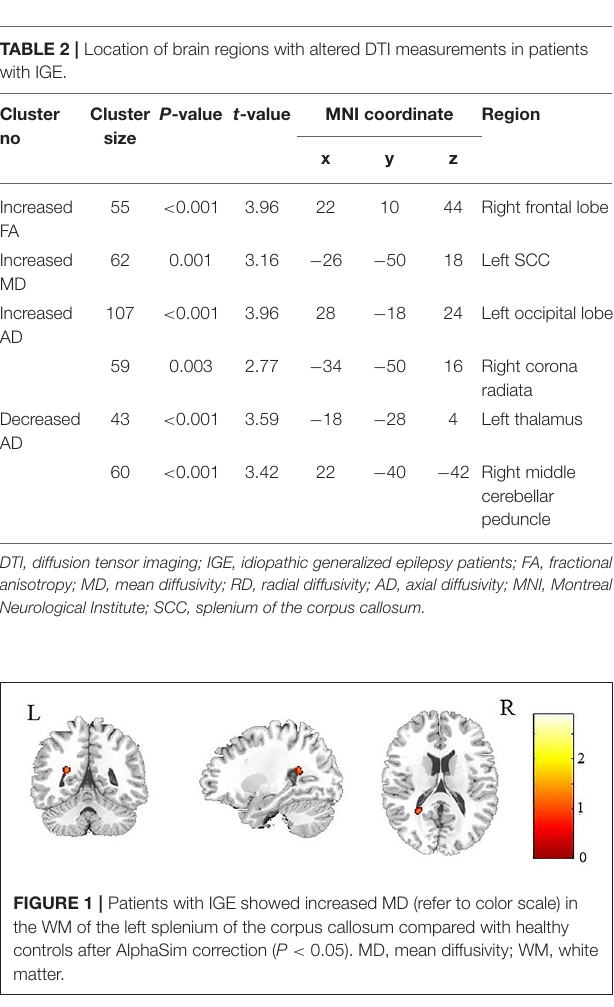
onset, duration of epilepsy, and cognitive measures, assessed by the mini-mental state examination